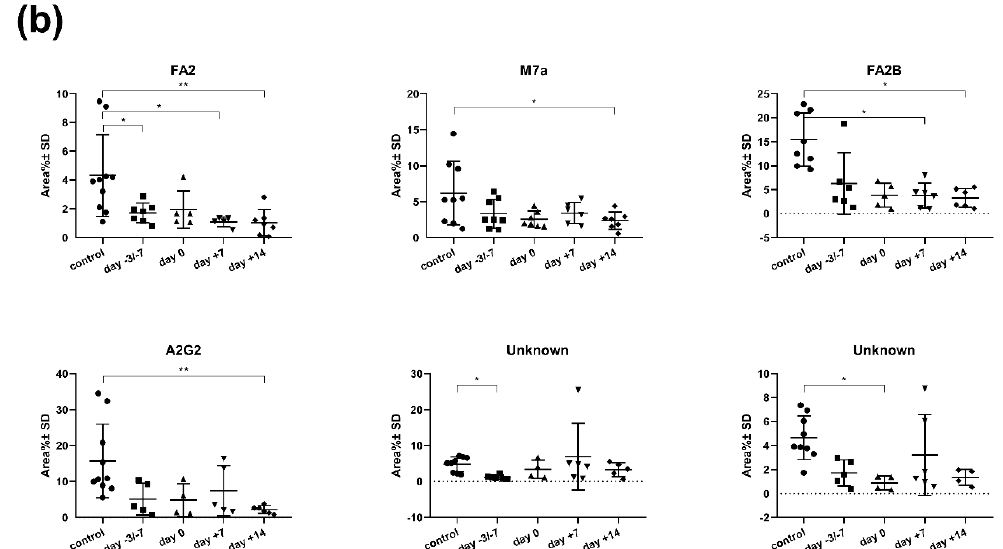
Figure 3. Fourteen serum ( a ) and six salivary ( b ) IgA glycoforms showed significant changes during autologous peripheral stem cell transplantation (APSCT). The abbreviations of the Oxford nomenclature were applied as referred to in our previous work [14]. The plots show the distribution pattern at various APSCT time points in patients and in controls (* p ˂ 0.05, ** p ˂ 0.01, *** p ˂ 0.001). For detailed results of statistical tests see also Table S3 and Table S4.